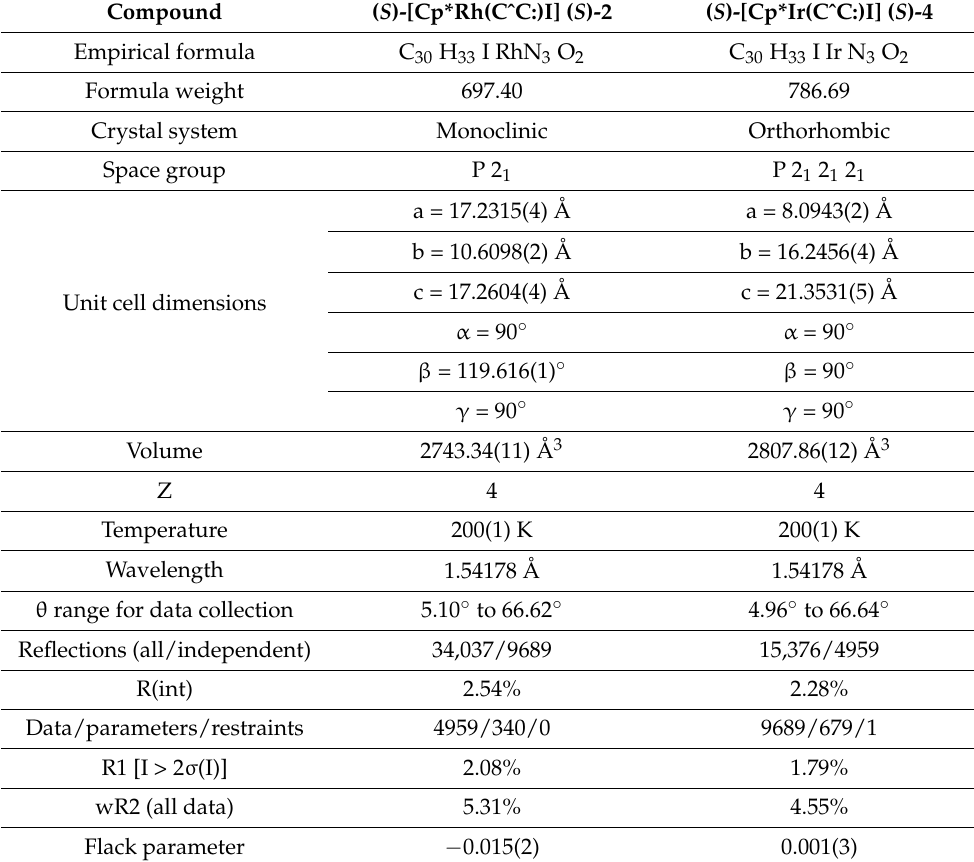
Summary of crystallographic, data collection and refinement parameters for ( S